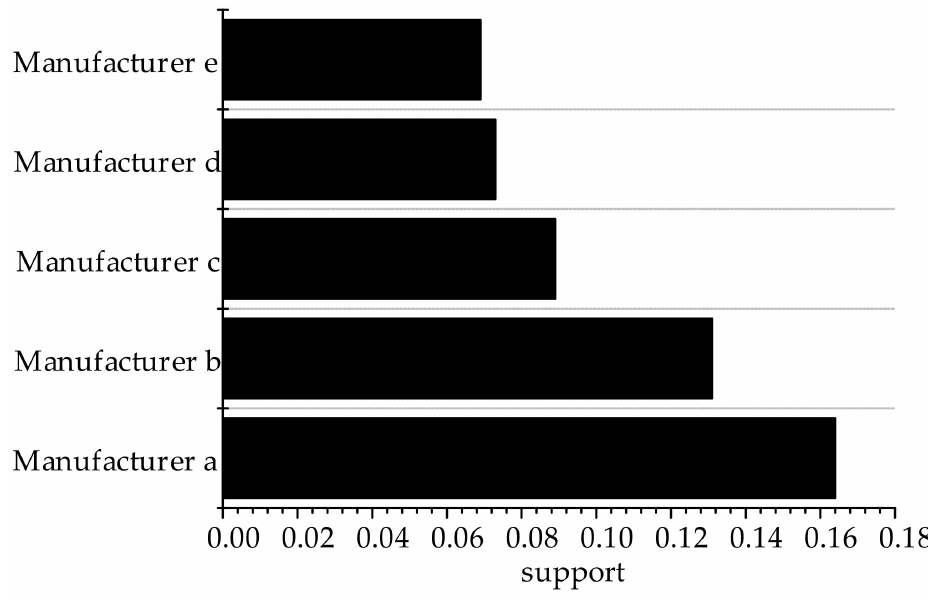
Figure 3. Manufacturer support.